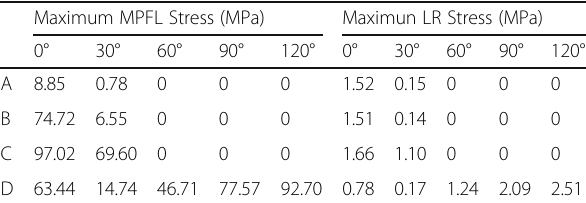
Table 6 MPFL and LR